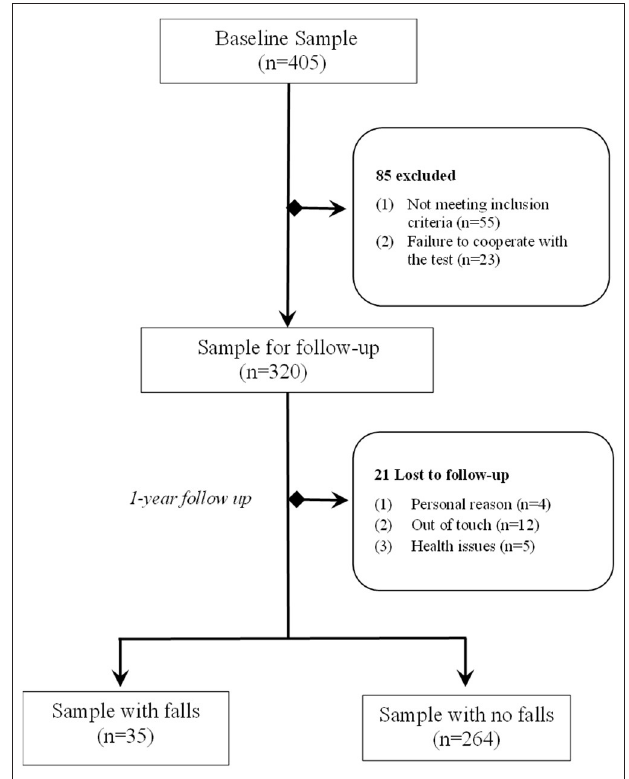
FIGURE 1 | Flowchart of the